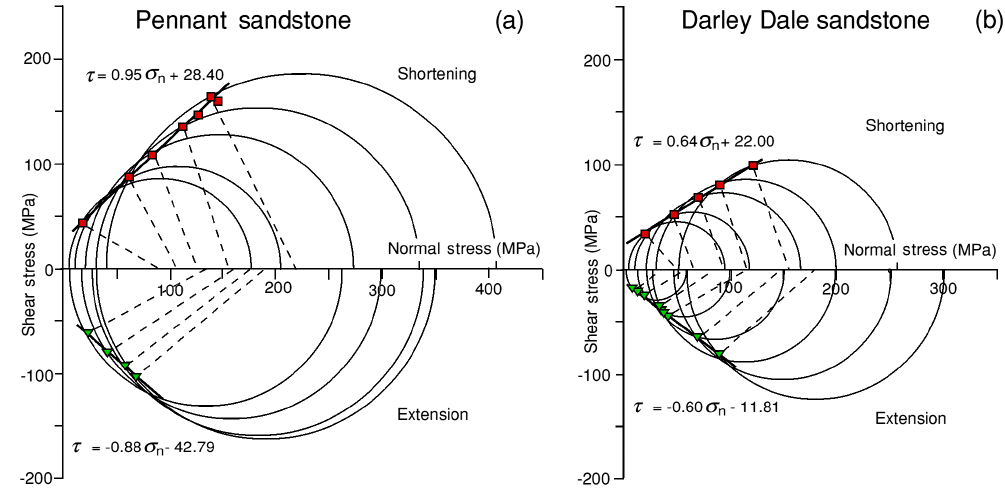
Figure 5. Some of the results for ultimate strength of Pennant and Darley Dale sandstones in extension and shortening expressed as Mohr circles at failure. Also shown are resolved normal and shear stresses at the point of failure on the fault planes that formed, the orientations of which are half of the angle subtended by the dashed lines with the abscissa. The Mohr envelopes are not shown, but they would lie at higher stresses than the best fits to the resolved stresses on the incipient fault planes. Fault angles are systematically larger in shortening than in extension, and the angles subtended by the normals to the Mohr envelopes are approximately half-way between these extremes.